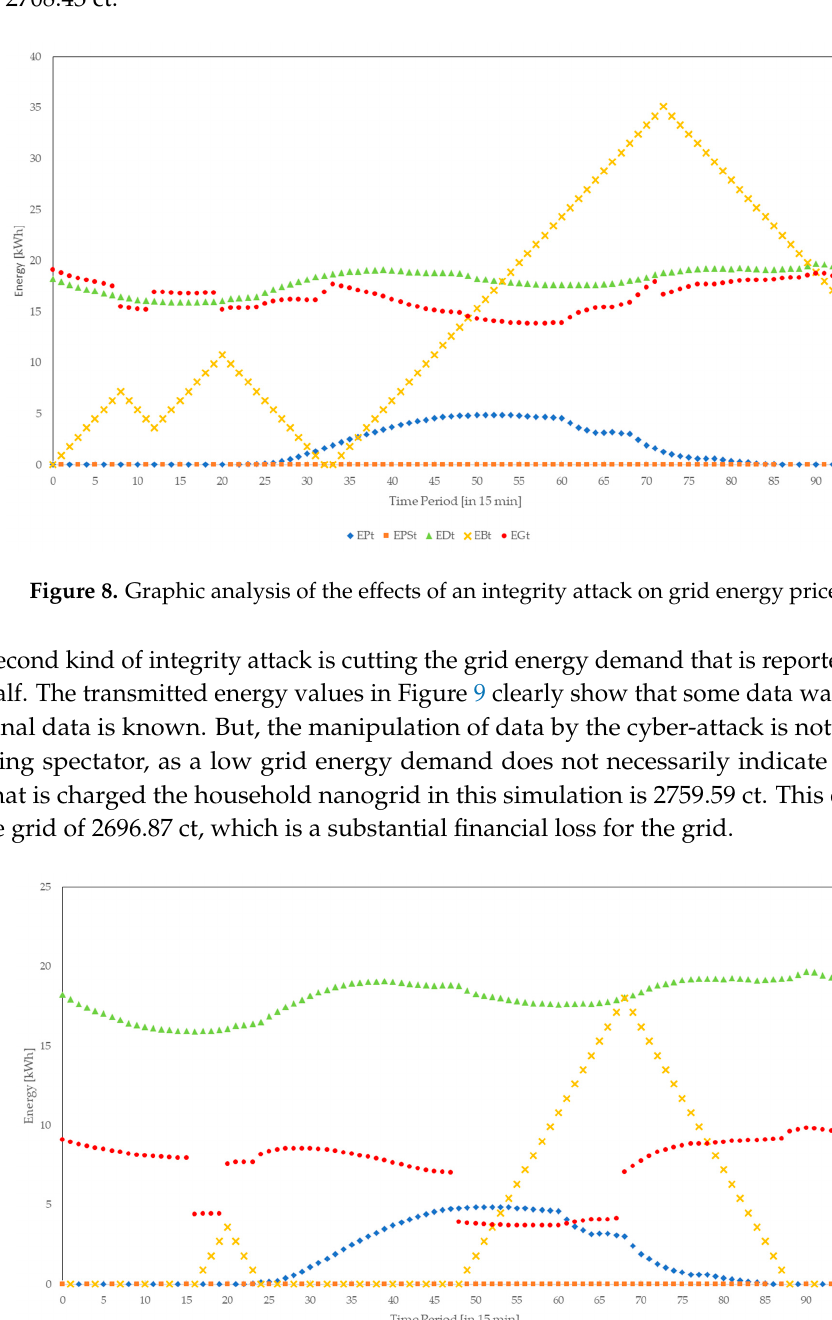
Figure 9. Graphic analysis of the effects of an integrity attack on grid energy demand.